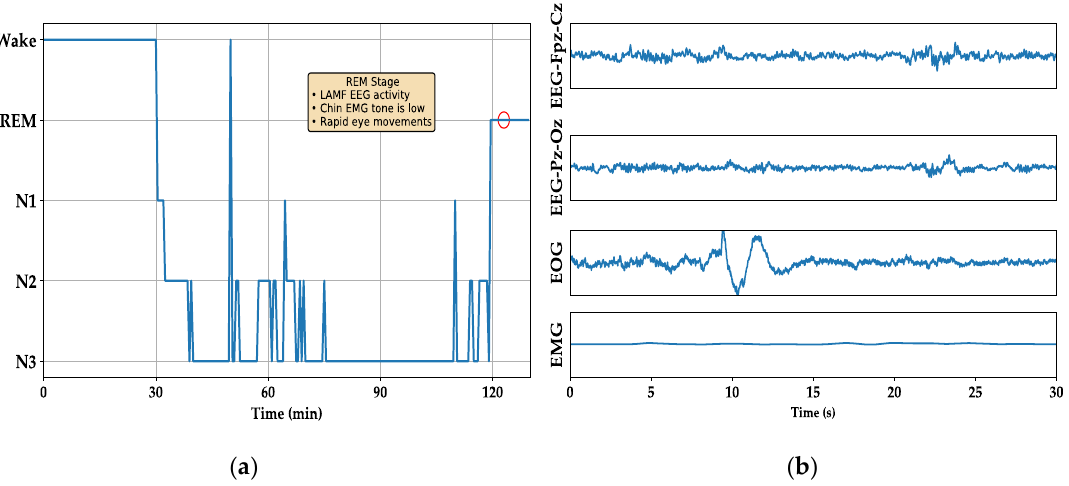
Figure 1. ( a ) Hypnogram of one sleep cycle. ( b ) Multi-channel physiological signal for the rapid eye movement (REM) stage corresponding to the red cycle in ( a ).